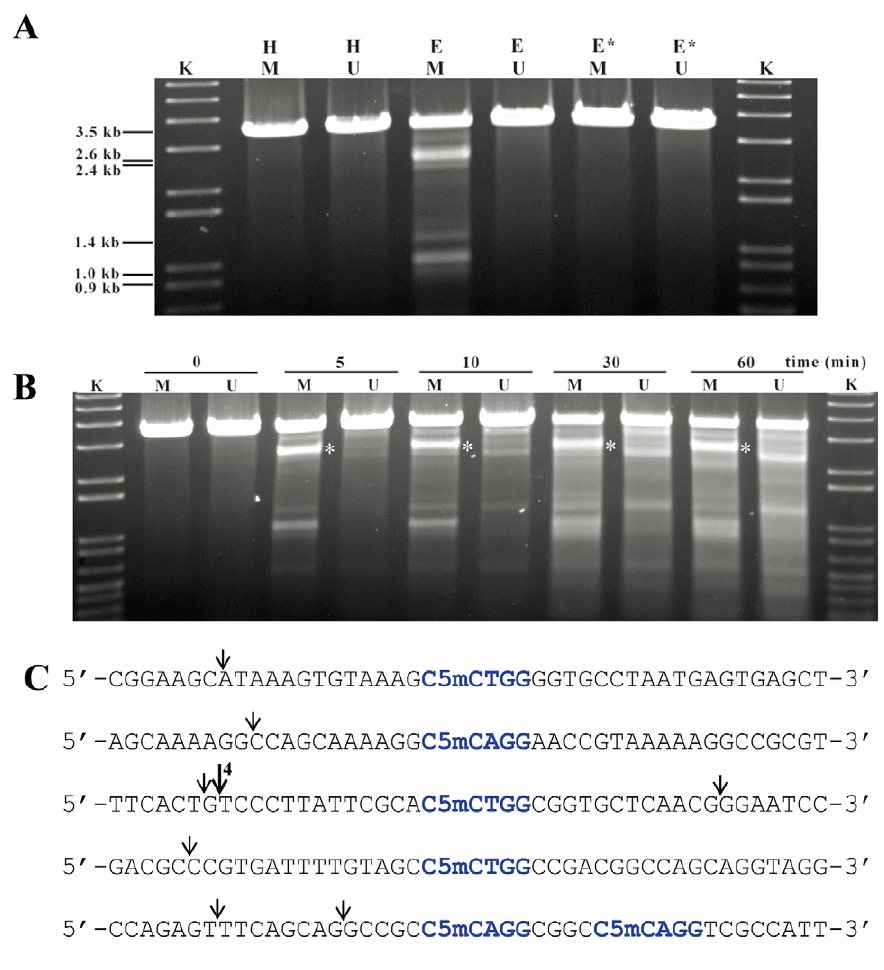
Figure 4. Sco4631-mediated invitro cleavage of Dcm-methylated plasmid DNA. A. Agarose gel showing that DNA cleavage by His 6 - Sco4631 requires DNA methylation. The ethidium bromide-stained agarose gel shows EcoRV linearized pOJ260 DNA treated as indicated above the lanes. Incubation was for 5 min at 30 u C in buffer containing 1 mM Mn 2 + . H, heat inactivated His 6 -Sco4631 used as a control; E (Enzyme) and E*, His 6 - Sco4631 and inactive His 6 -Sco4631(H508A), respectively, purified from E. coli BL21(DE3); K, kb ladder DNA standard; M (methylated), indicates Dcm methylated pOJ260 that was prepared from Dam + Dcm + host E. coli DH10B. U (unmethylated), indicates pOJ260 that was isolated from